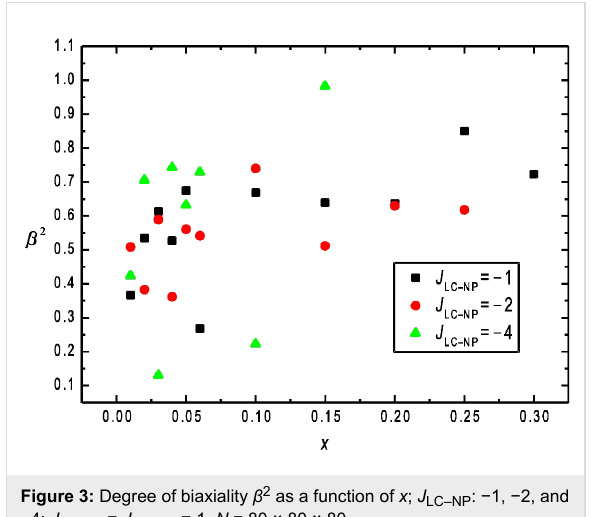
Figure 3: Degree of biaxiality β 2 as a function of x ; J LC–NP : − 1, − 2, and − 4; J LC–LC = J LC–NP = 1, N = 80 × 80 ×